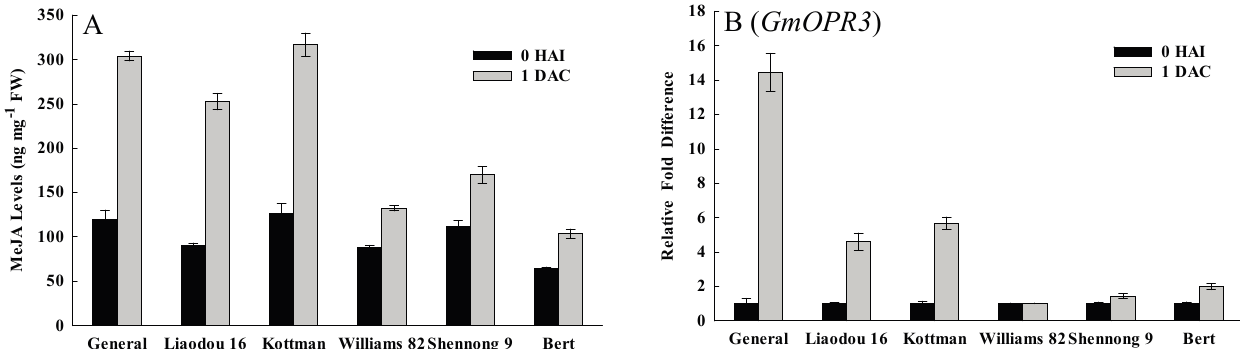
Figure 7. Comparison of methyl jasmonate (MeJA) levels and the expression levels of MeJA synthetic gene between different genotypes. The values represent means ± SD based on three biological replications. ( A ) MeJA content in cotyledonary nodes after 0 h of infection and after one day of co-cultivation; ( B ) qRT-PCR analysis of MeJA synthetic gene GmOPR3 .